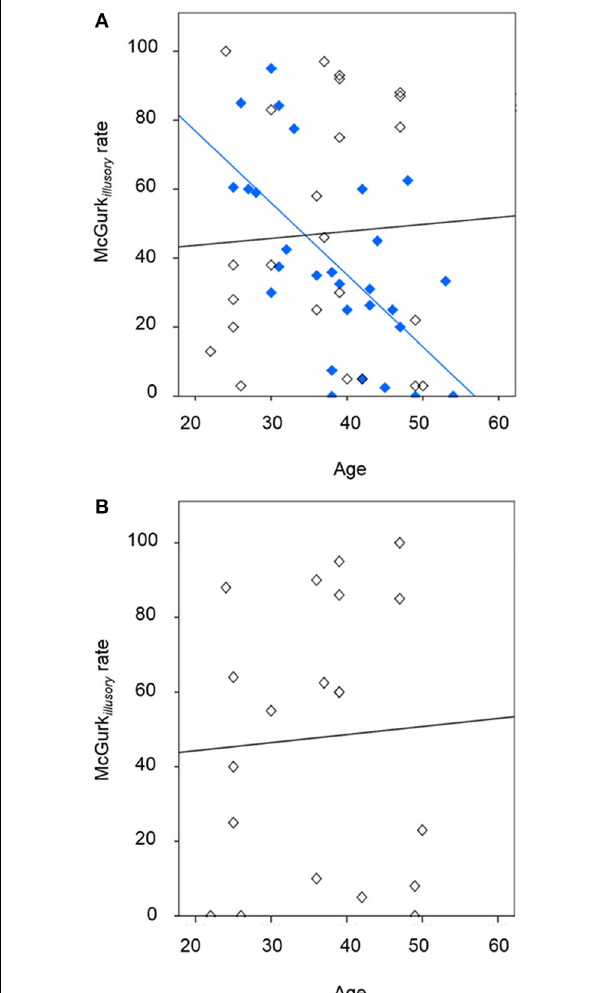
FIGURE 2 | The relationship between illusory perception and age, showing (A) the schizophrenia group (in blue; R 2 of best-fit line: 0.414) and healthy individuals following placebo (in black; R 2 of best-fit line: 0.003), and (B) the healthy individuals following amisulpride (in black; R 2 of best-fit line: 0.003).